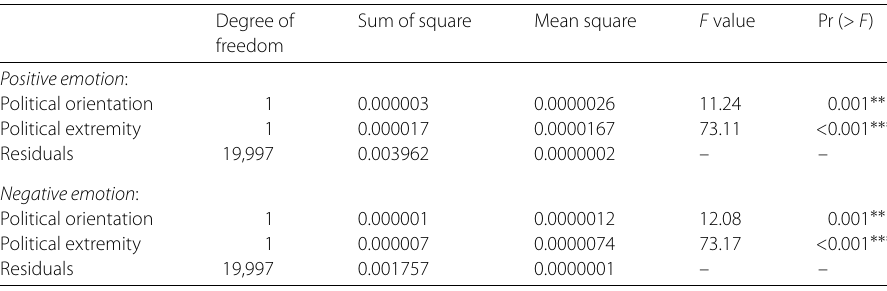
Table 9 Multi-group mean comparisons of anxiety using Tukey’s HSD test Mean 95% Confidence interval Adjusted difference P-valueLower Upper bound bound lwe-lw 0.0005 0.0002 0.0009 <0.001 ∗∗∗ rw-lw –0.0001 –0.0005 0.0002 0.73 rwe-lw –0.0005 –0.0008 –0.0001 <0.001 ∗∗∗ rw-lwe –0.0007 –0.001 –0.0003 <0.001 ∗∗∗ rwe-lwe –0.001 –0.0014 –0.0006 <0.001 ∗∗∗ rwe-rw –0.0003 –0.0007 0 0.07